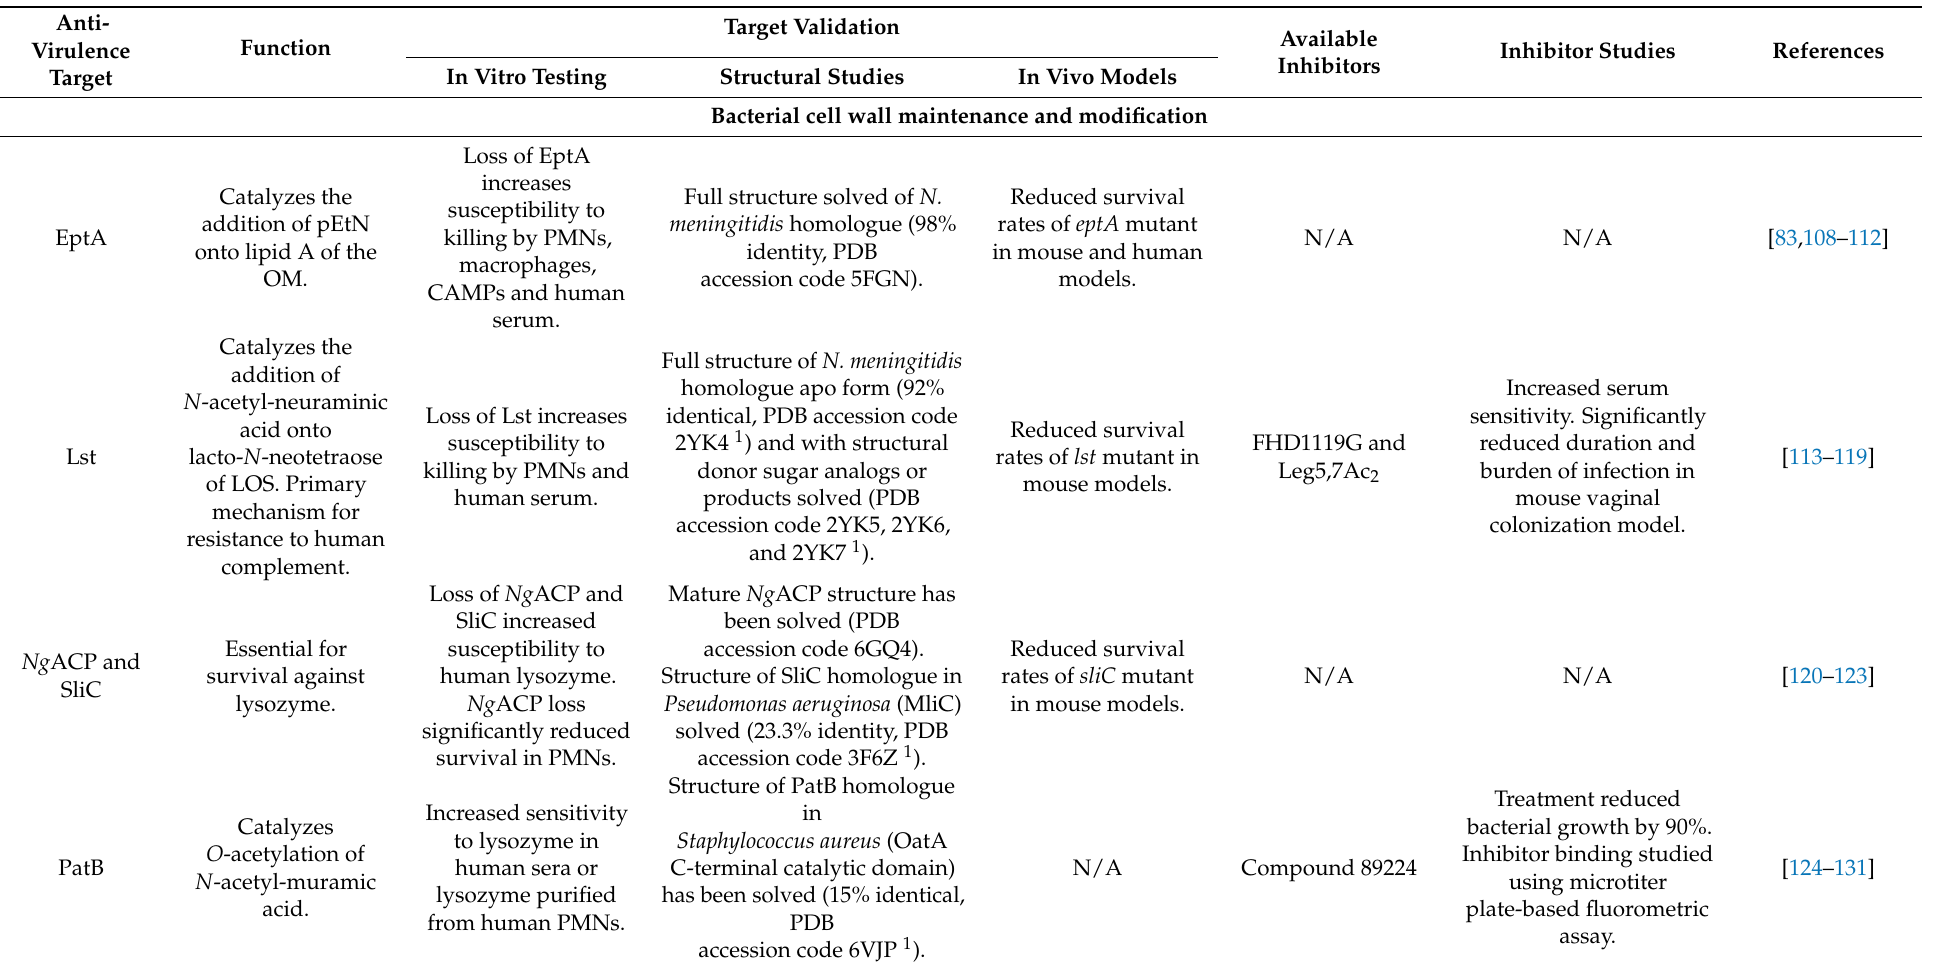
Table 1. Summary of anti-virulence targets in N. gonorrhoeae